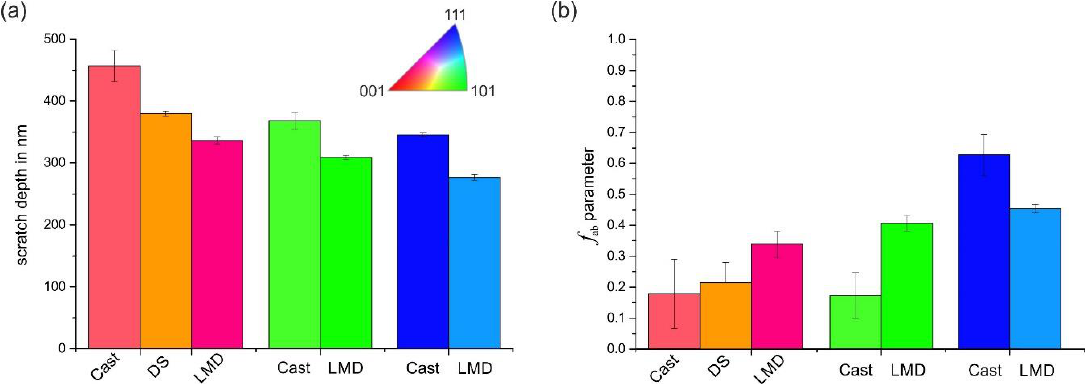
Figure 11. ( a ) Scratch depth and ( b ) f ab parameter of the investigated specimens and grain orientations.